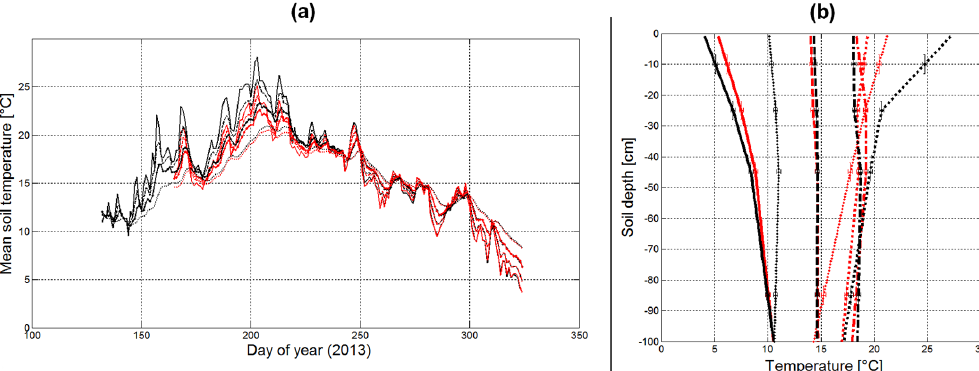
Figure 6. Space-time dynamic of soil temperature at the summit (red) and the footslope (black) position in 2013: (a) time series at different depths; (b) profile at different dates. The legend of the curves in relation to the different depths and dates is given in Fig. 7.